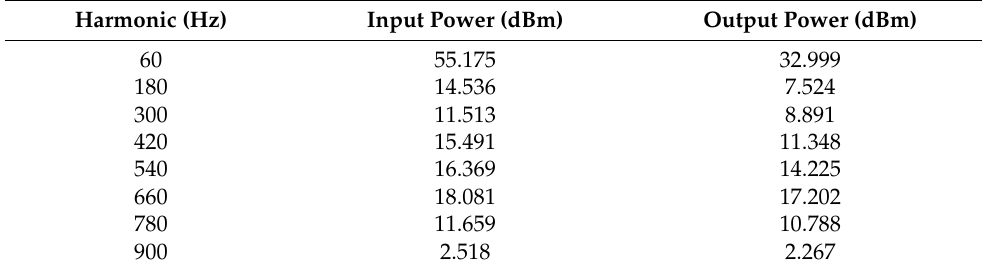
Figure 14. Magnitude spectrum of the voltage signal at the output of the NB–PLC notch coupling circuit. Table 4. The power of the main and of a few harmonics components at the input and output of the NB–PLC notch coupling